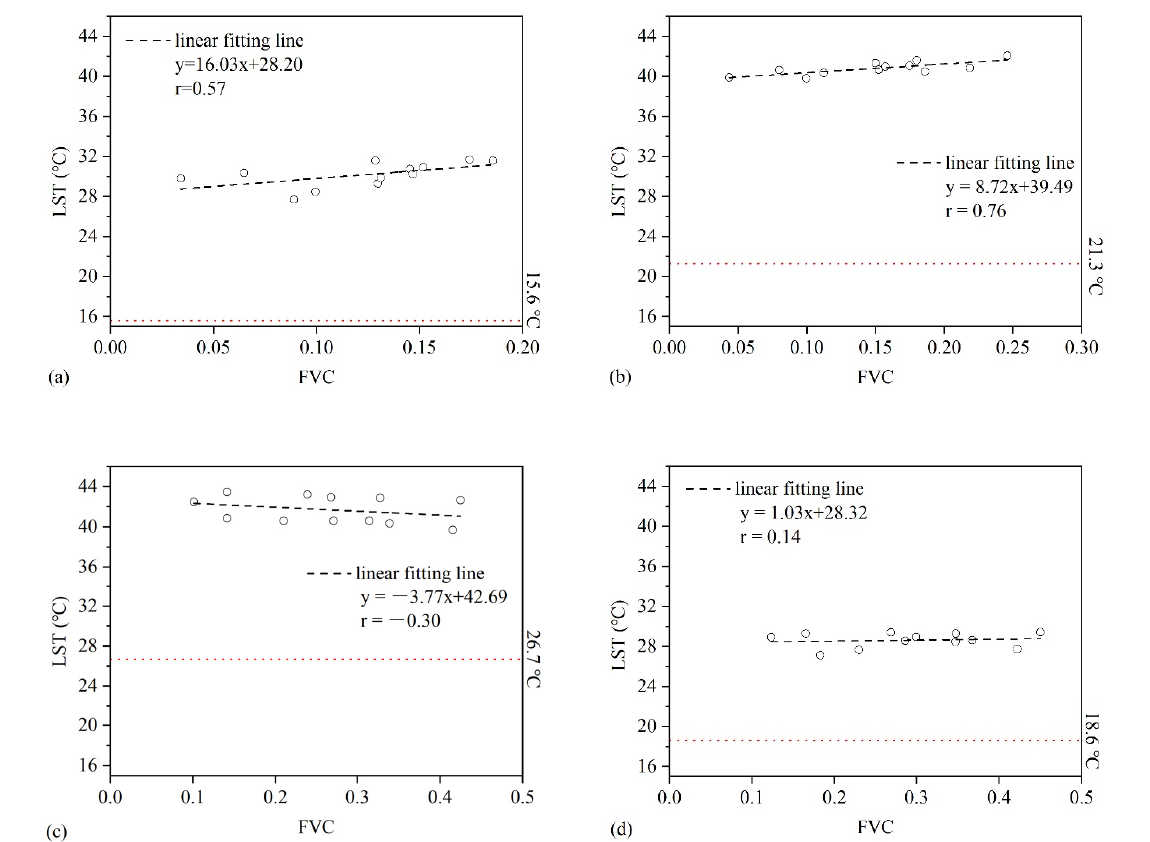
Figure 3. Relationship between FVC and LST at sample area scale on P1–P4 (( a ), P1; ( b ), P2; ( c ), P3; ( d ), P4. The red dotted line is the average air temperature observed by Naiman and Kulun field stations on the same day).